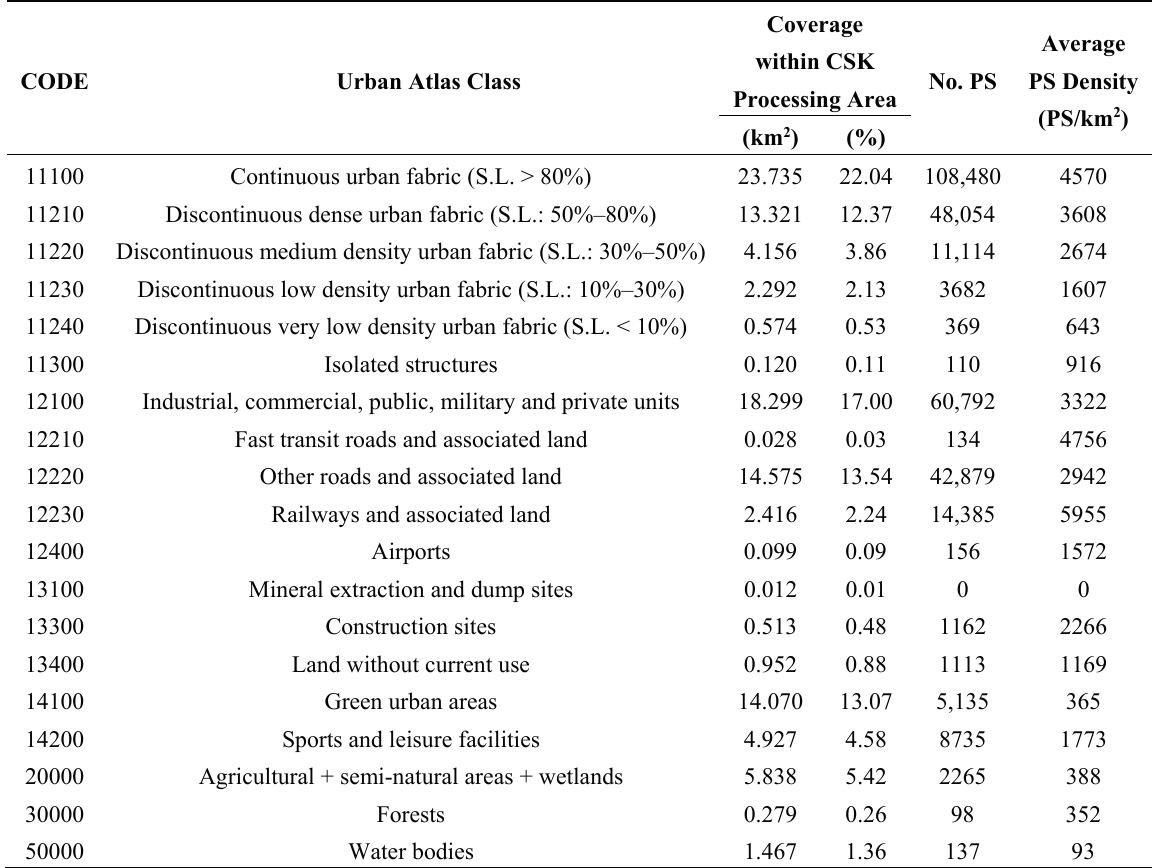
Table 1. Observed number and average density of COSMO-SkyMed (CSK) PS for the different land cover classes of the Urban Atlas within the processed subset ( cf . Figure 2). Sealing Layer,